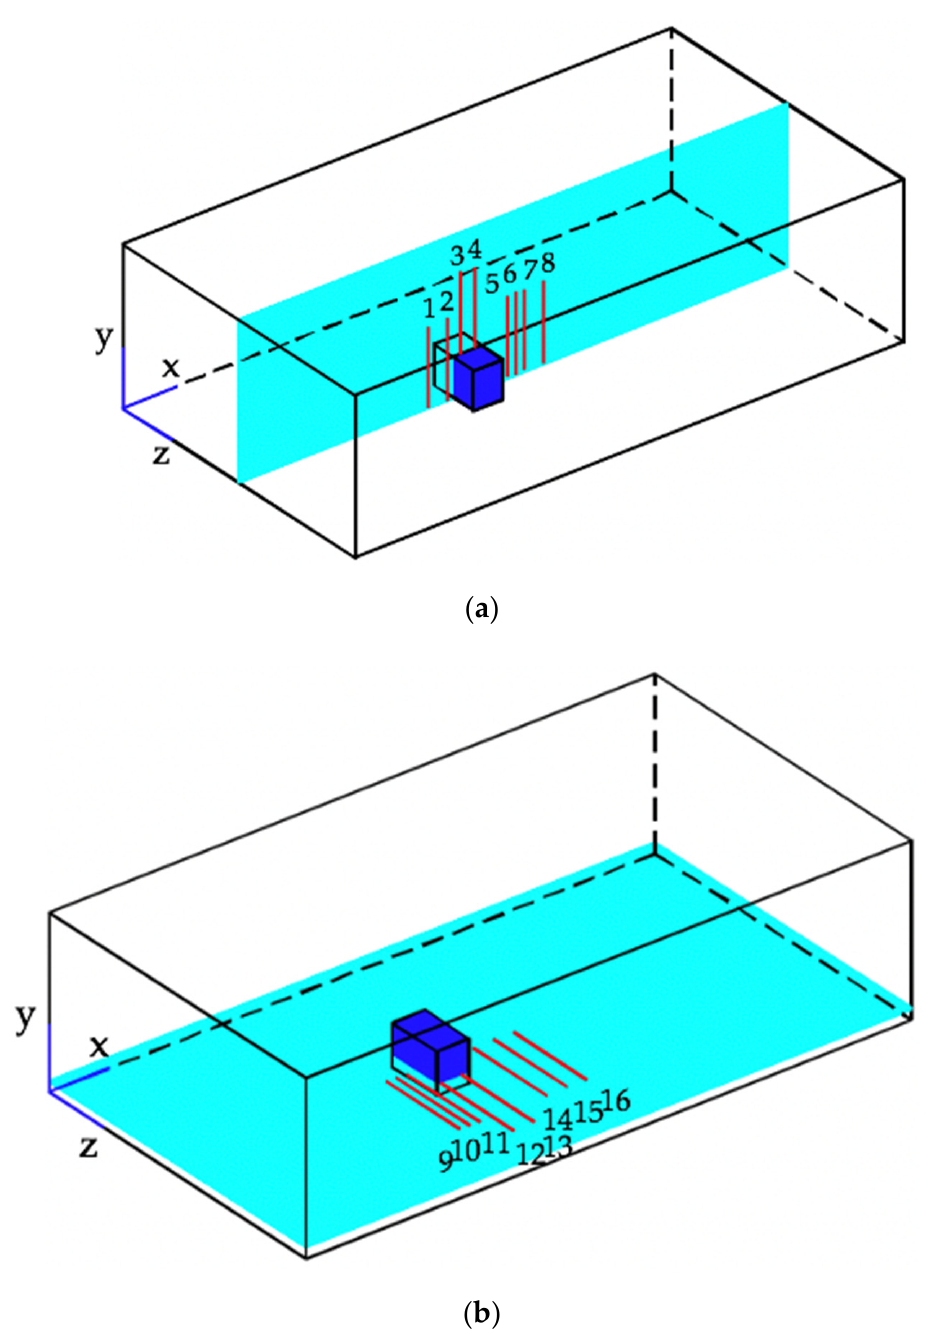
Figure A3. Schematic representation of the vertical and horizontal measurement sections locating on the ( a ) symmetry plane, z = 0.325 m, and ( b ) a near-surface plane, y = 0.035